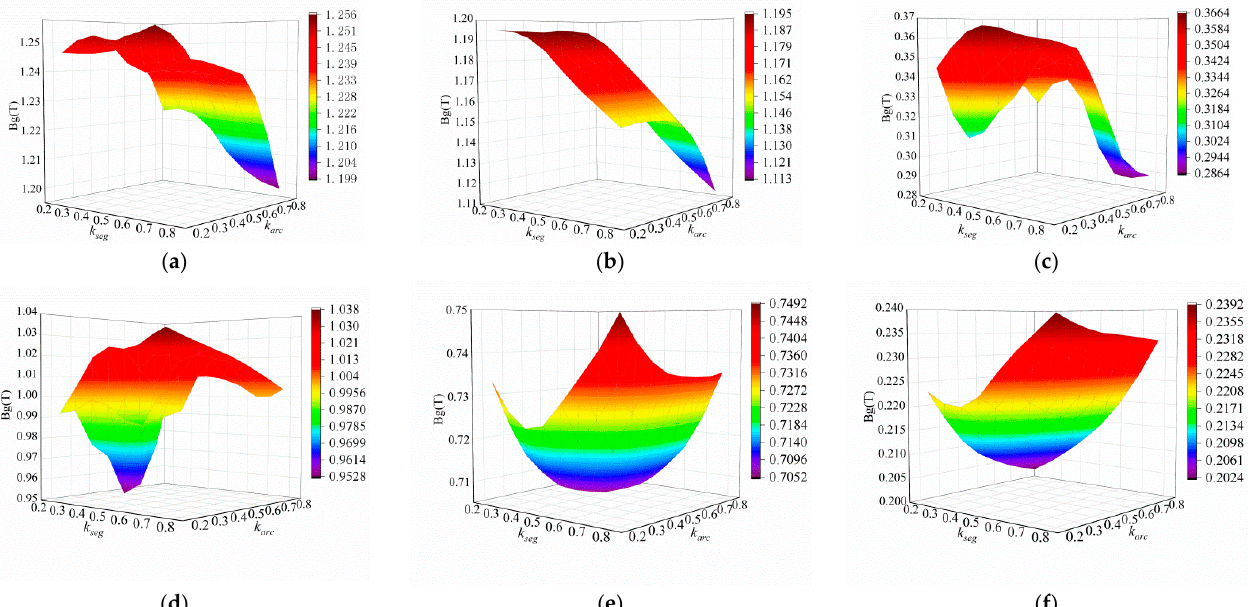
Figure 7. The influence of cross-shaped flux-barriers parameters on flux density in each region of air-gap: ( a ) region A1; ( b ) region A2; ( c ) region A3; ( d ) region A4; ( e ) region A5; ( f ) region A6.